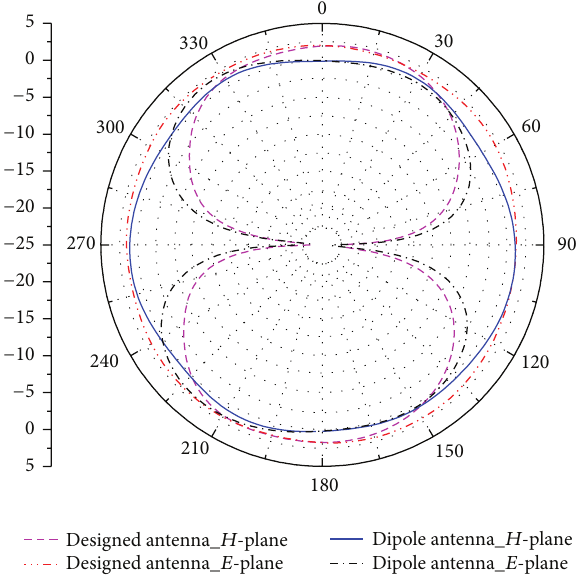
Figure 12: Simulated radiation patterns of designed antenna and dipole